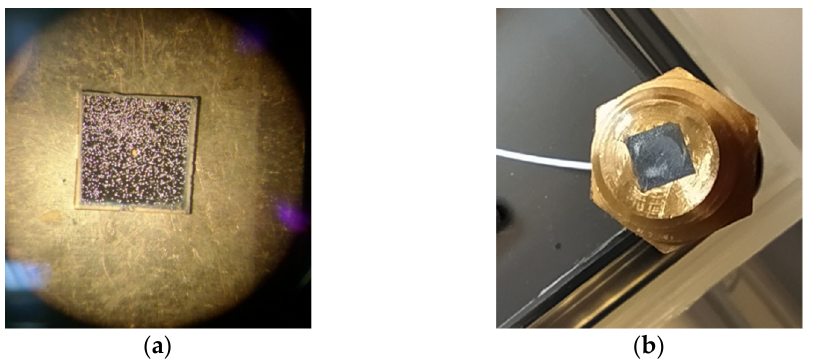
Figure 8. ( a ) Optical microscope image of a 5 mm × 5 mm diamond-on-silicon sample before membrane alignment and fixing on a brass holder. The bright spots are due to reflected light by the diamond microcrystals. In the center, the diamond membrane (~300 µ m in diameter) is clearly visible, being completely transparent to white light. ( b ) A picture of a diamond membrane on silicon glued on the brass holder used for sensor characterization.